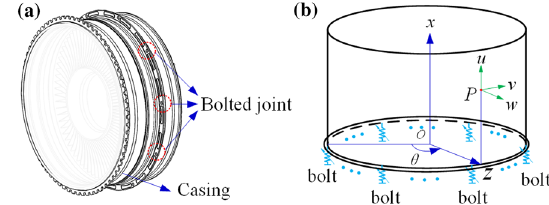
Figure 1 Sketch of cylindrical shell with bolted joints and